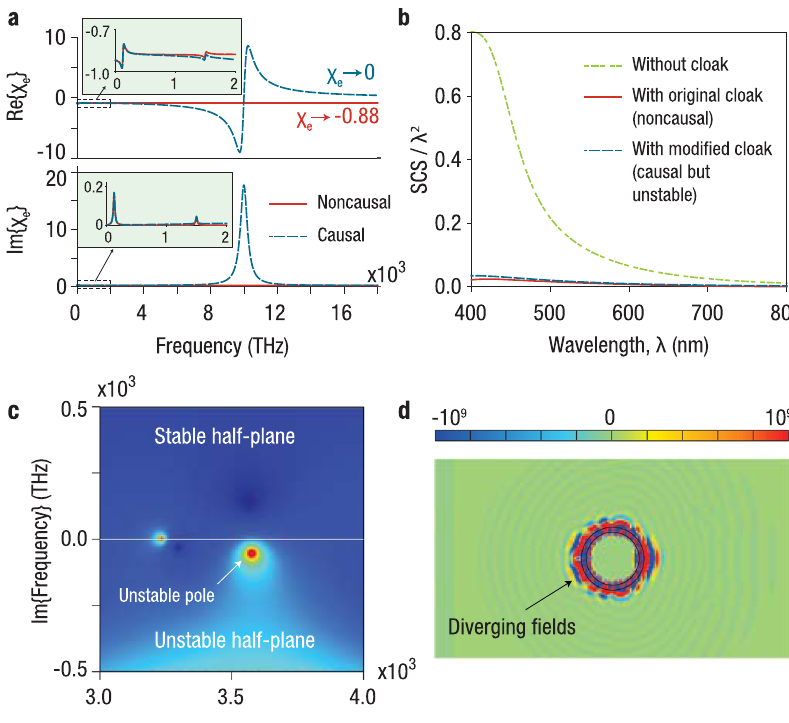
Fig. 2 Physical limitations of invisibility cloaks made of fast-light media due to relativistic causality and stability. a Electric susceptibility (top panel, real part; bottom panel, imaginary part) of the original fast-light (gain doublet) cloaking material in Fig. 2 of ref. 1 (red solid curve) and a modi fi ed causal version of this material (blue dashed curve). The material models considered in ref. 1 violate relativistic causality because the high-frequency limit of the susceptibilities is non-zero and negative. The main panels show the high-frequency limit and the insets show the frequency range of interest for cloaking operation. b Normalized scattering cross section (SCS) based on exact analytical calculations (Mie theory 20 ) for the uncloaked and cloaked spherical dielectric objects considered in Fig. 2 of ref. 1 . The plot shows the scattering spectra of both the original non-causal cloak, and the modi fi ed causal (but unstable) cloak, corresponding, respectively, to the red and blue curves in a . c Magnitude of the scattering coef fi cient for electric dipole scattering from the causal cloaked sphere, plotted on the complex frequency plane, revealing the presence of an unstable pole. d Electric fi eld distribution (time snapshot of the x -component) around the causal cloaked sphere on the xz -plane. The fi eld pro fi le is shown for a broadband pulse after the pulse has propagated for a duration of 4 fs, clearly showing the diverging fi elds around the cloaked object due to the onset of unstable (unbounded) oscillations. This implies that the low SCS for the cloaked cases in b is physically irrelevant since the cloaking material is either temporally non-causal or unstable. The scale bar is normalized to the maximum amplitude of the incident wave. Time-domain animation of the fi eld distribution in d is given in Supplementary Video